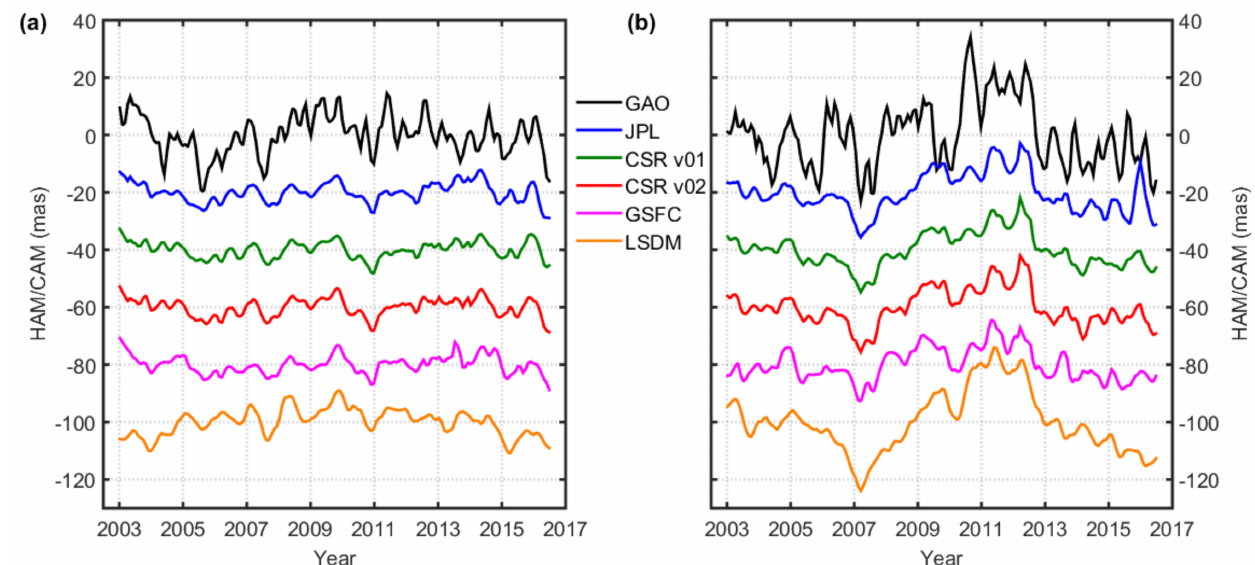
Figure 7. Comparison of non-seasonal time series of the ( a ) χ 1 and ( b ) χ 2 components of GAO, GRACE-based HAM/CAM, and LSDM-based